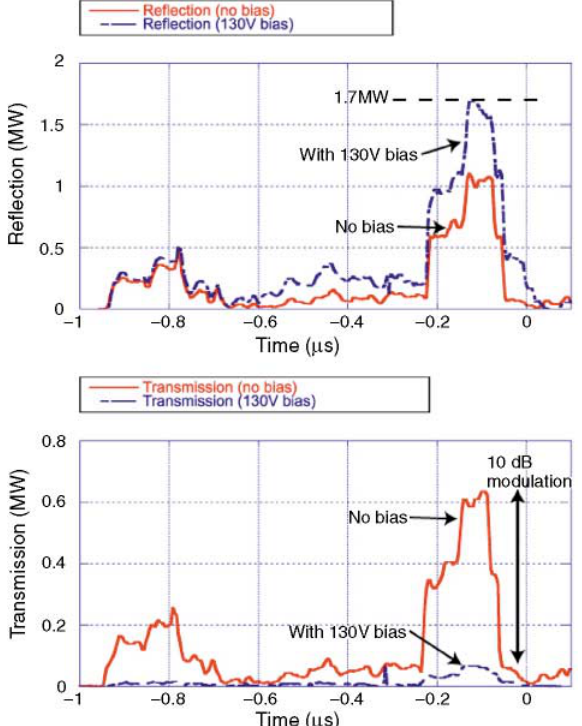
FIG. 24. (Color) Waveform with zero bias and 130 V forward